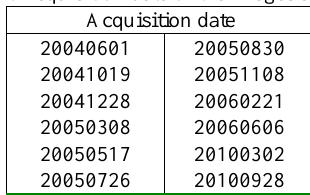
Table 1. Acquisition date of the images available